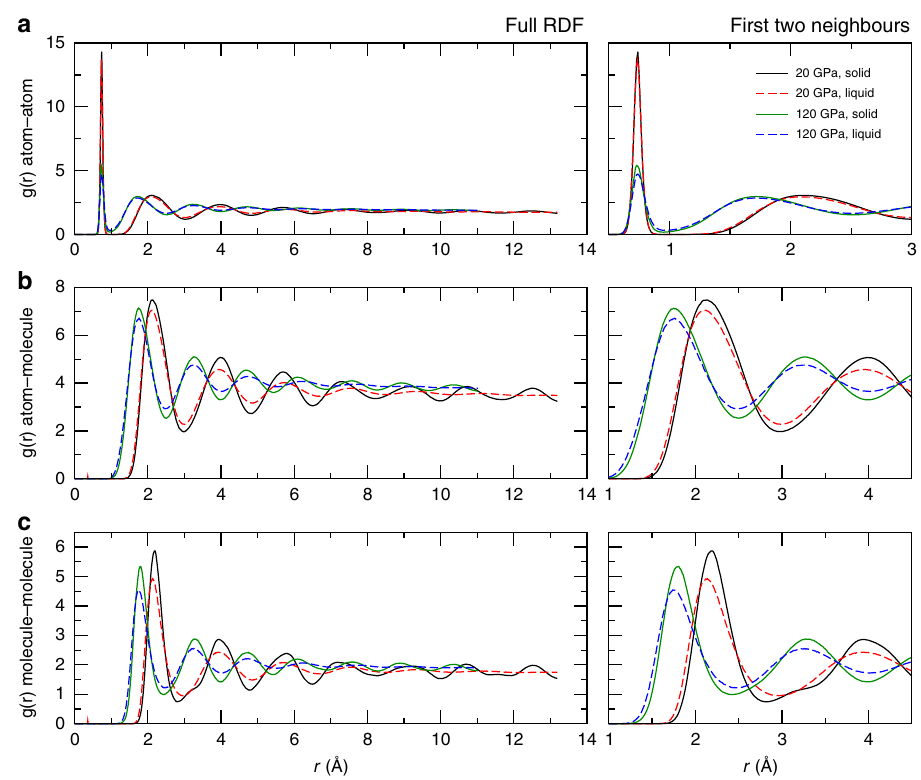
Fig. 4 Radial distribution functions (RDFs) of co-existing solid and liquid. a Atom – atom RDFs, b atom – molecule RDFs and c molecule – molecule RDFs, with the full length shown on the left and a close-up of the fi rst two neighbour shells on the right. The RDFs show that the liquid can pack more tightly than the hcp solid phase. This is true both at 20 GPa, which is before the turnover in the Clapeyron slope, and at 120 GPa, well into the negative slope region. The higher density of the liquid is most apparent in the molecule – molecule RDF. These RDFs are on good agreement with the RDFs obtained from AIMD simulations 45 .